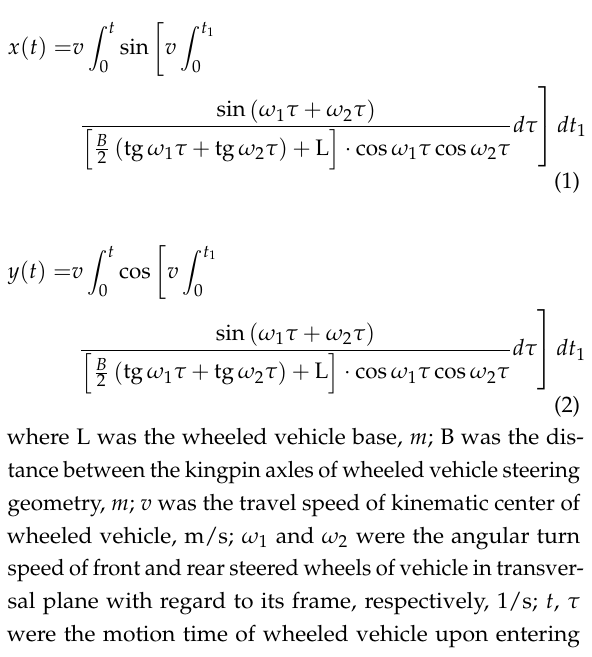
= 32 ◦ , α ′′ = 0 ◦ ; (b) method I at v = 1.37 m / s : L = 2.6 m , B = 1.8 m , ω 2 1